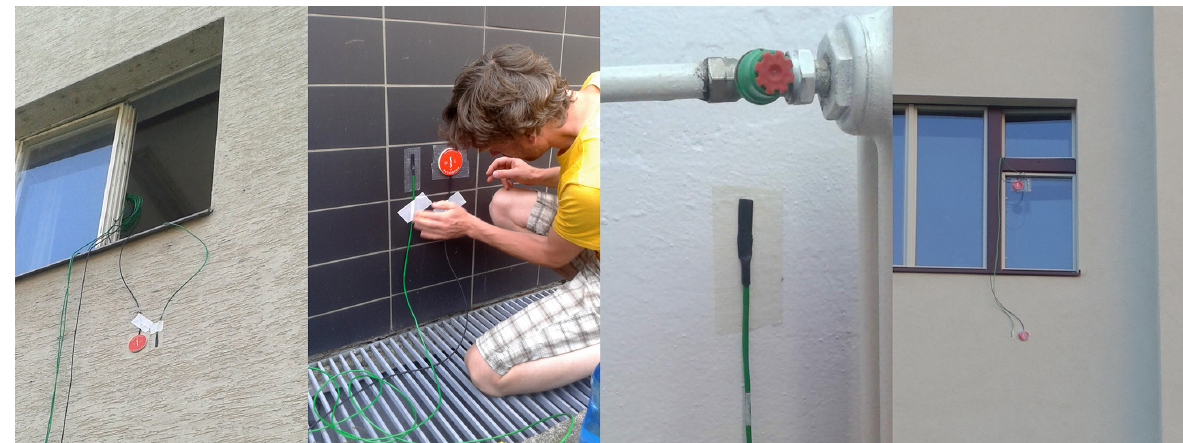
Figure 2. Details of heat flux sensor and thermocouple mounting. The left panel shows the first floor of Sinkule house, the centre-left panel shows the ground floor of Sinkule house, the centre-right panel shows the inner temperature sensor on the ground floor of Sinkule house, and the right panel shows Zelená Street. For the Sinkule house and Zelená Street locations, see Fig.